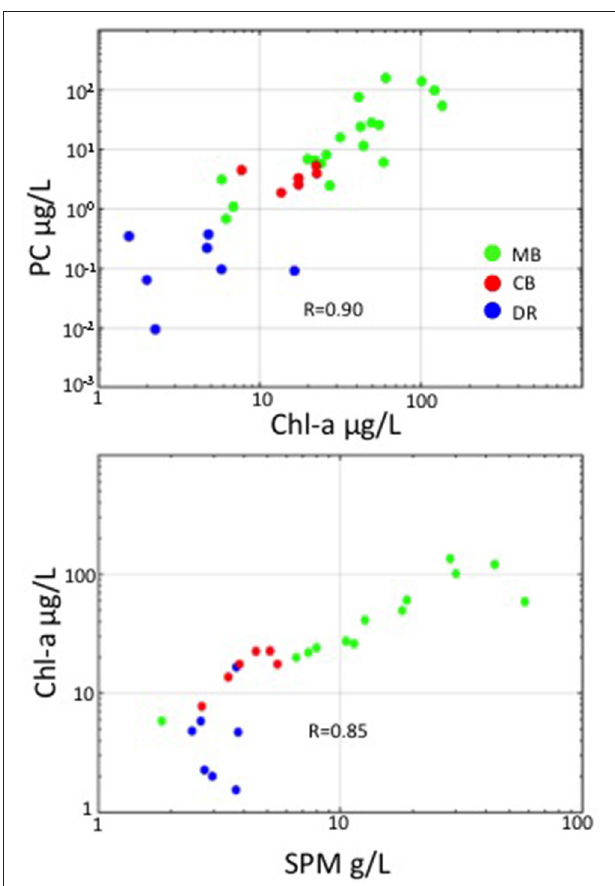
FIGURE 2 | In-water relationships among Chl-a , PC , and SPM . Top : PC versus Chl-a (on log scales); Bottom : Chl-a versus SPM (on log-scale). Points are color-coded by